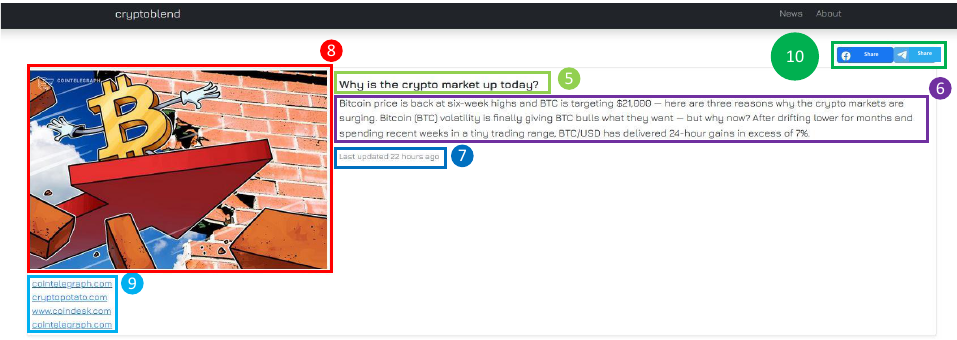
Figure 3. Graphics of a blend’s page, in which the different parts are enumerated as in Figure 2, with the exception of the button (10) that allows for sharing the blend’s content on the social